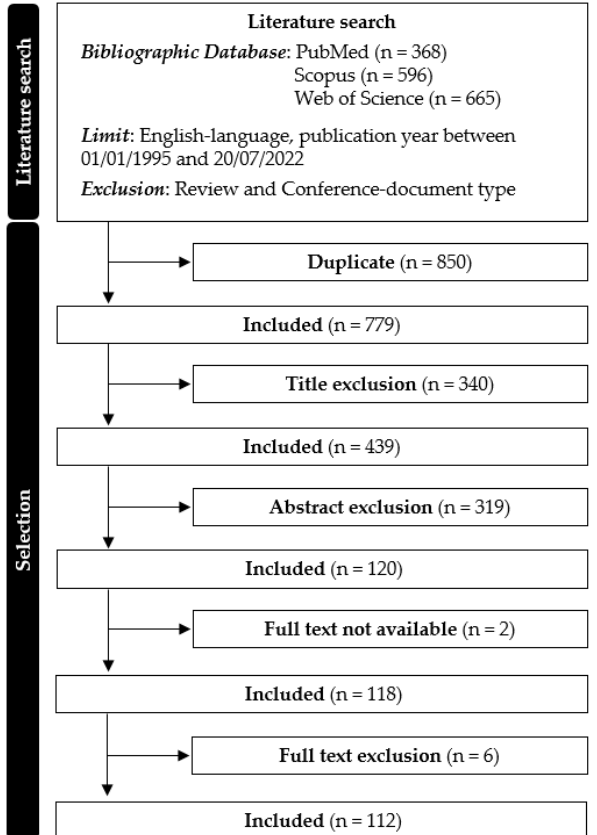
Figure 1. Flow chart describing the selection process (modified from